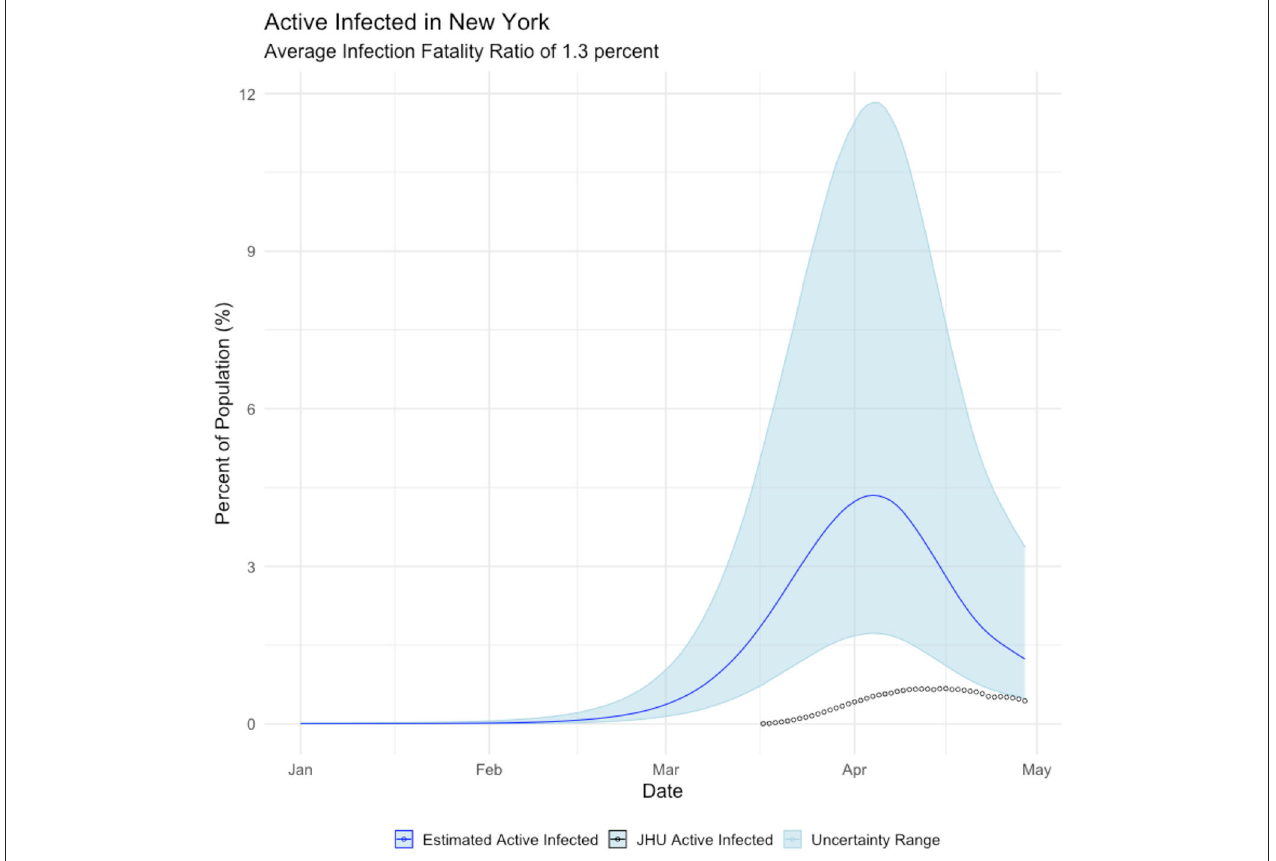
FIGURE 4 | Relationship between estimated active infections (blue line), and active infections derived from the Johns Hopkins COVID19 site (black circles).